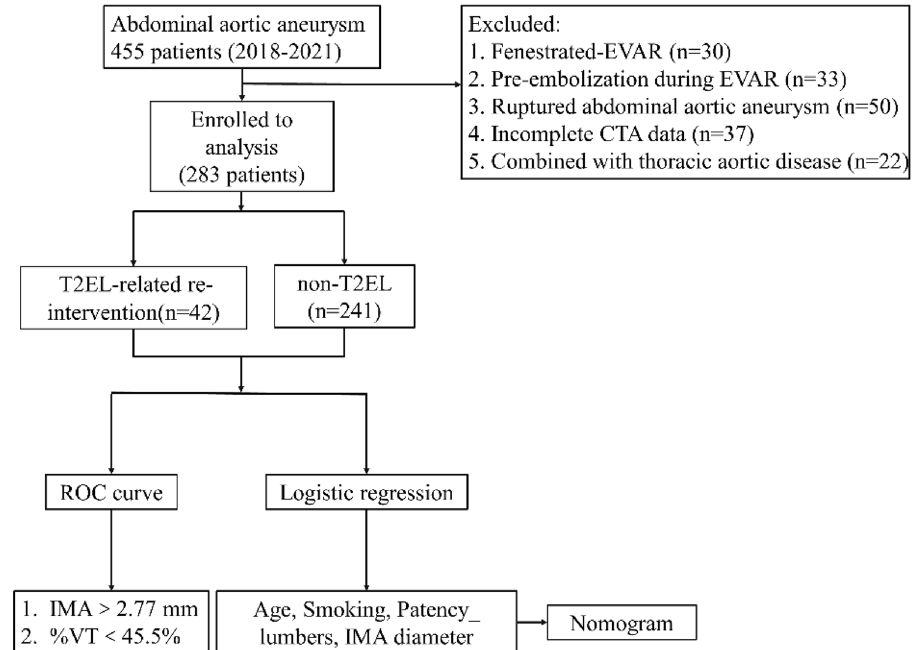
Figure 1. Flow chart Retrospective analysis process and patient exclusion